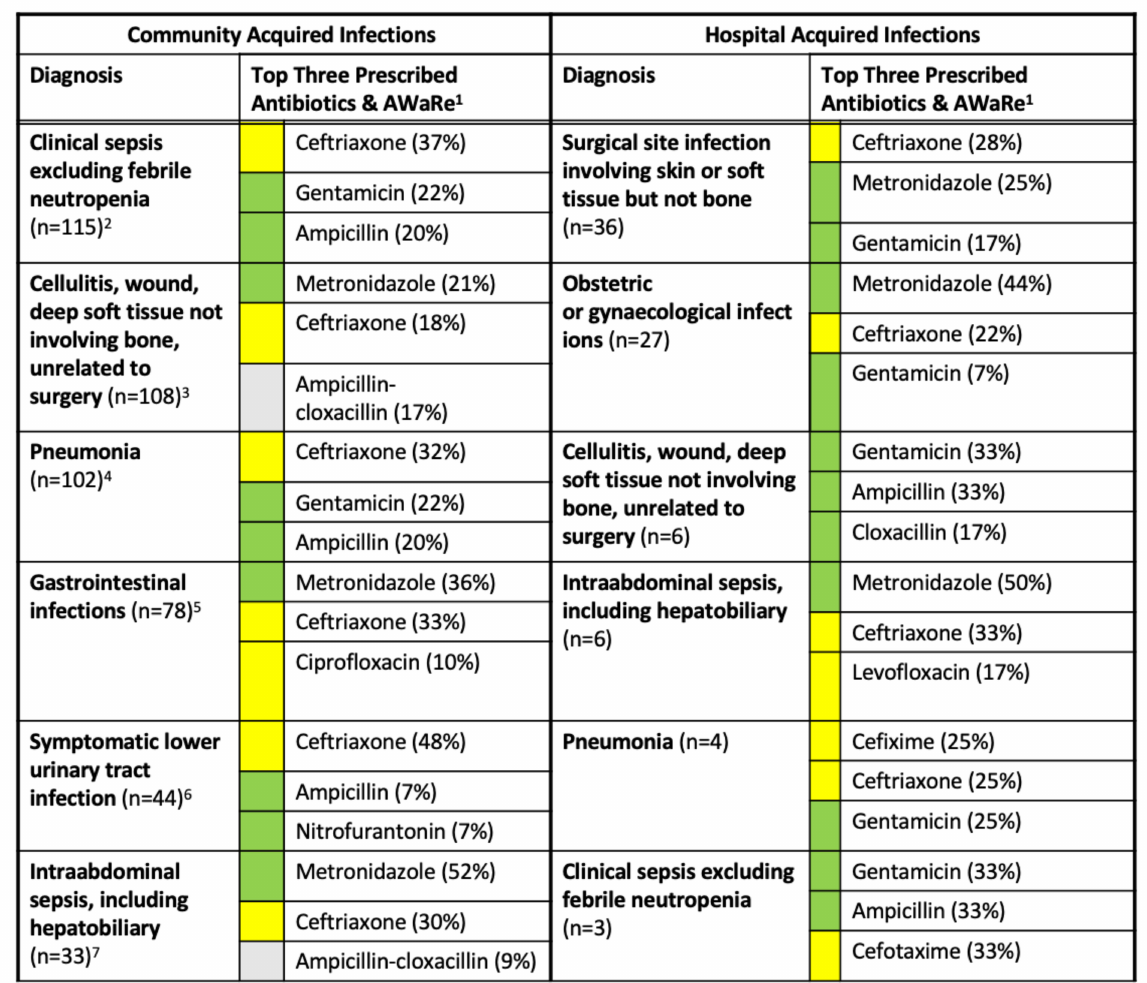
Figure 2. Top three antibiotics prescribed for various diagnoses and their AWaRe classification.